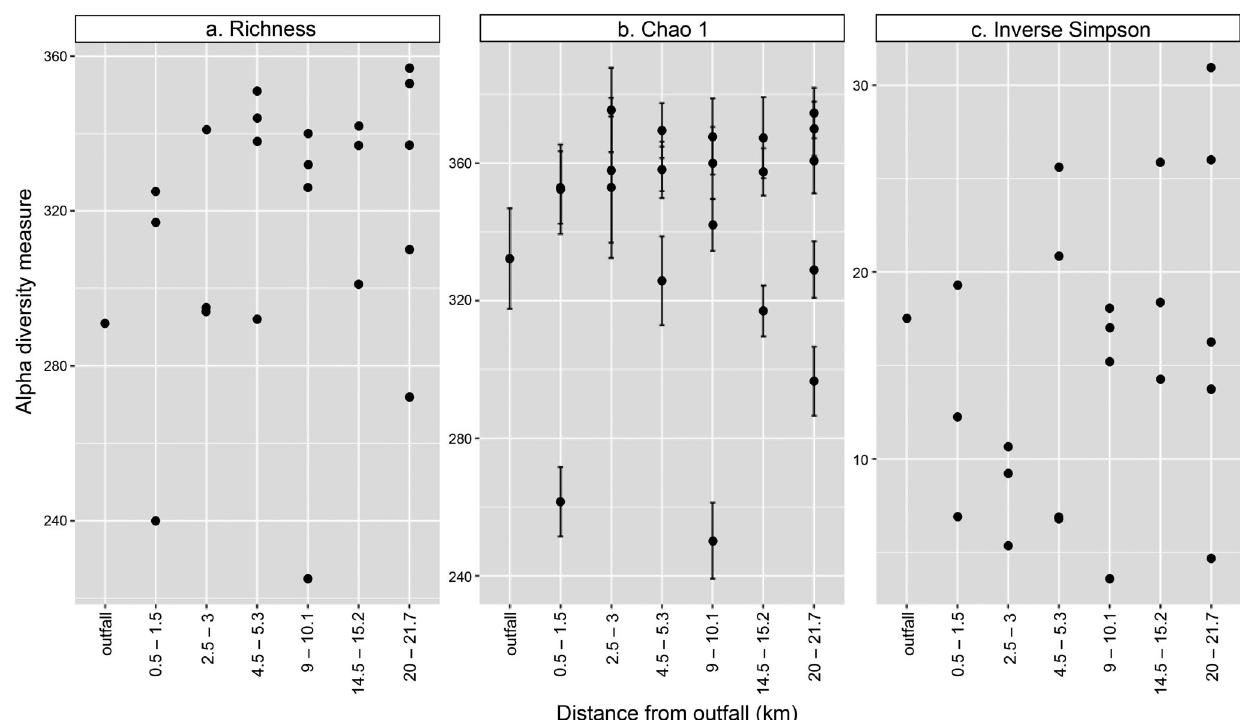
Fig. 3. Measures of alpha diversity based on bacterial and archaeal small subunit ribosomal RNA (SSU rRNA) genes at each sampling site: (a) community richness (e.g. number of operational taxonomic units), (b) Chao1 estimator (bars: 95% confidence intervals), and (c) inverse Simpson index. Data are organized into groups based on distance from the